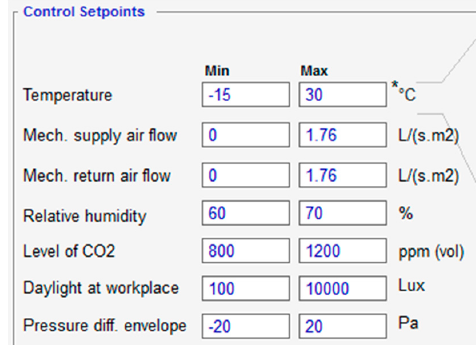
Figure 9. Indoor air ventilation quantity and quality set points.